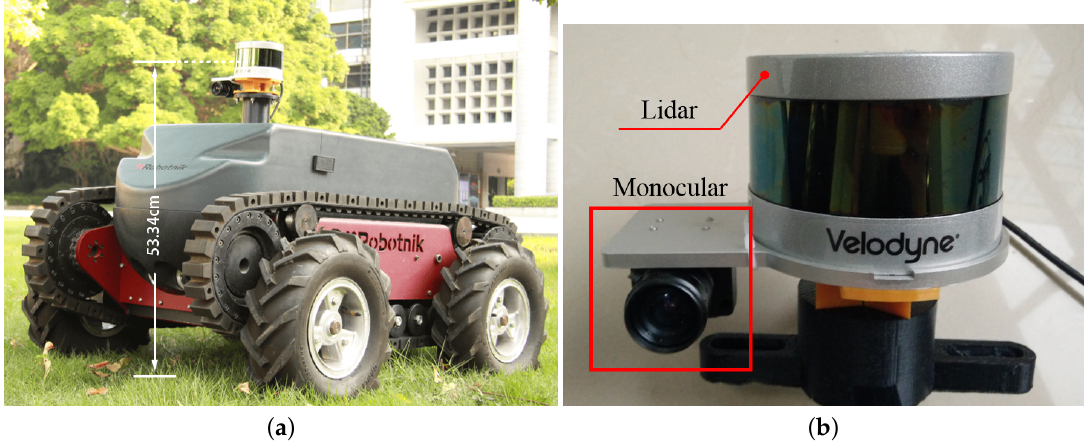
Figure 8. Our experimental platform: ( a ) Robotnik Guardian equipped with a monocular camera and a 3D LIDAR, and ( b ) sensor module including a Pointgrey FMVU-03MTM-CS and a Velodyne